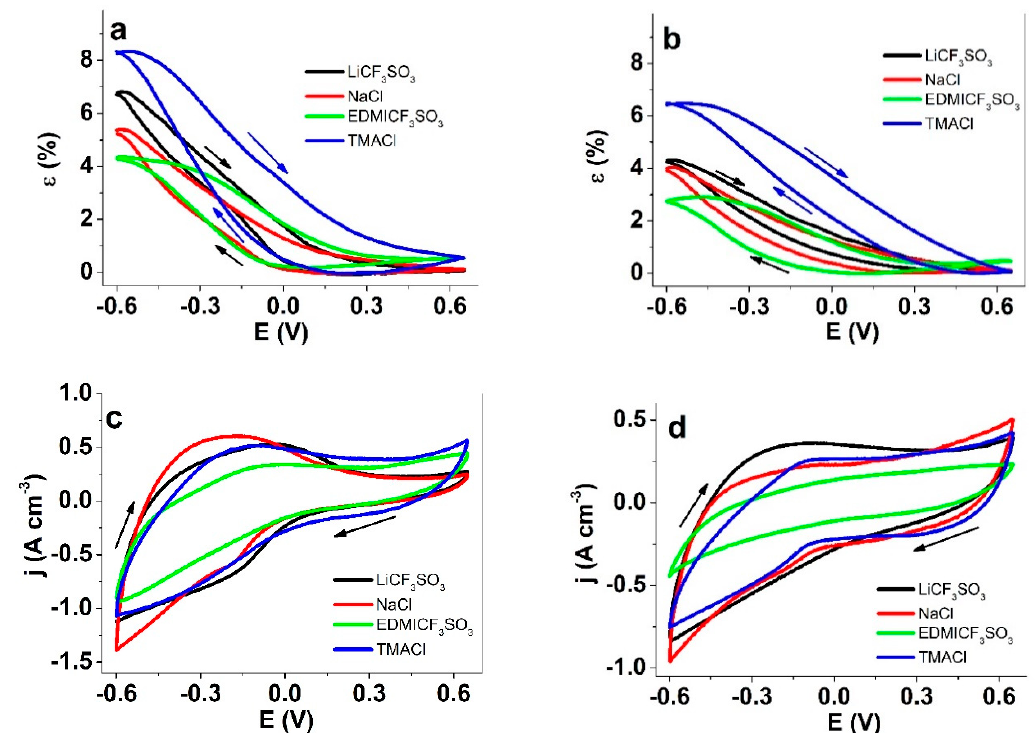
Figure 4. Steady state responses of films submitted to potential cycles (scan rate 5 mV s − 1 ) between 0.65 to − 0.6 V against Ag / AgCl (3 M KCl) in aqueous solutions of LiCF 3 SO 3 (black), NaCl (red), EDMICF 3 SO 3 (green) and TMACl (blue) ( a ): strain, ε , of PPy-PEO / DBS films; ( b ): strain, of PPy / DBS; ( c ): current density, j, of PPy-PEO / DBS films; and ( d ): current densities, of PPy / DBS films. The arrows indicate the scan direction.